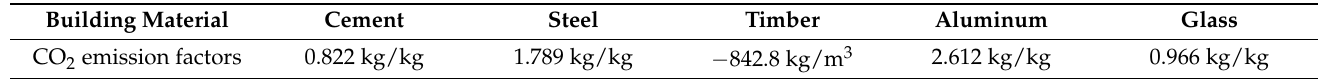
Table 2. CO 2 emission factors of construction industry